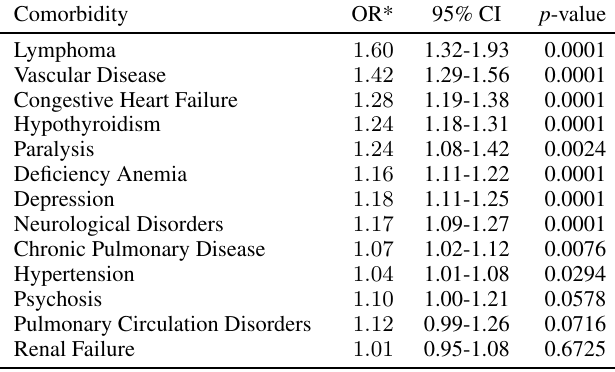
Table 3: Elevated comorbidities in patients with SS compared to controls.